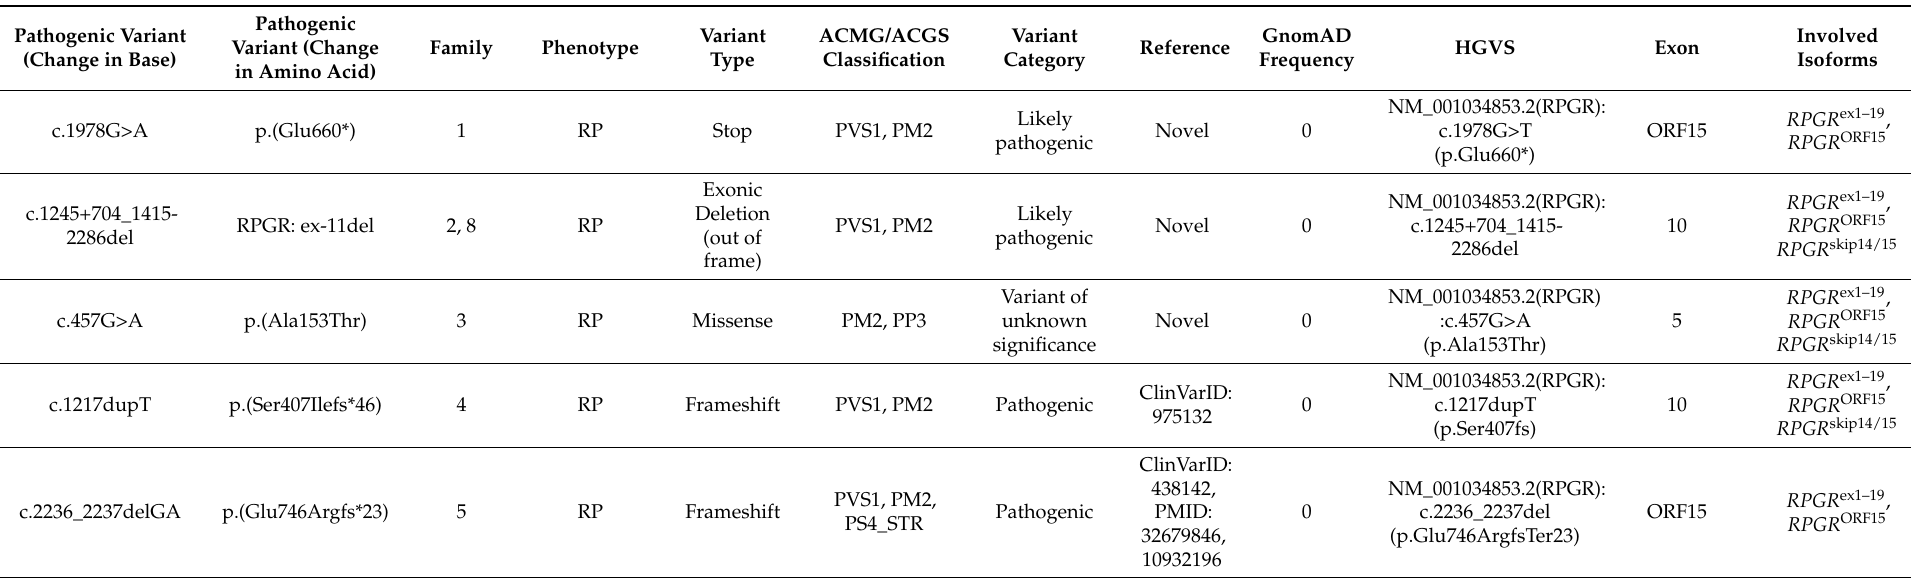
Table 2. Characteristics of RPGR variants found in the Slovenian